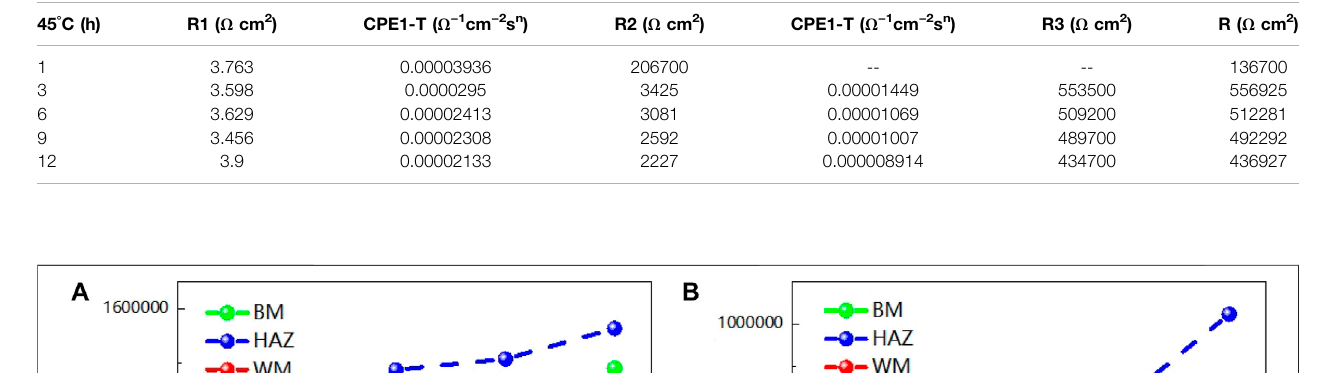
TABLE 11 | Impedance fi tting data of weld zone soaked in arti fi cial seawater at 45 ° C for 12 h